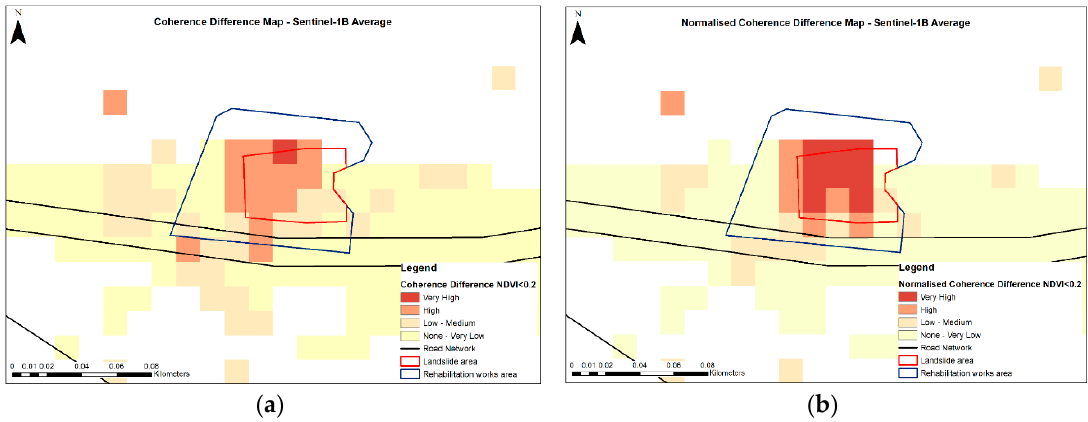
Figure 21. ( a ) Coherence difference and ( b ) normalized coherence difference maps – Sentinel – 1B average.